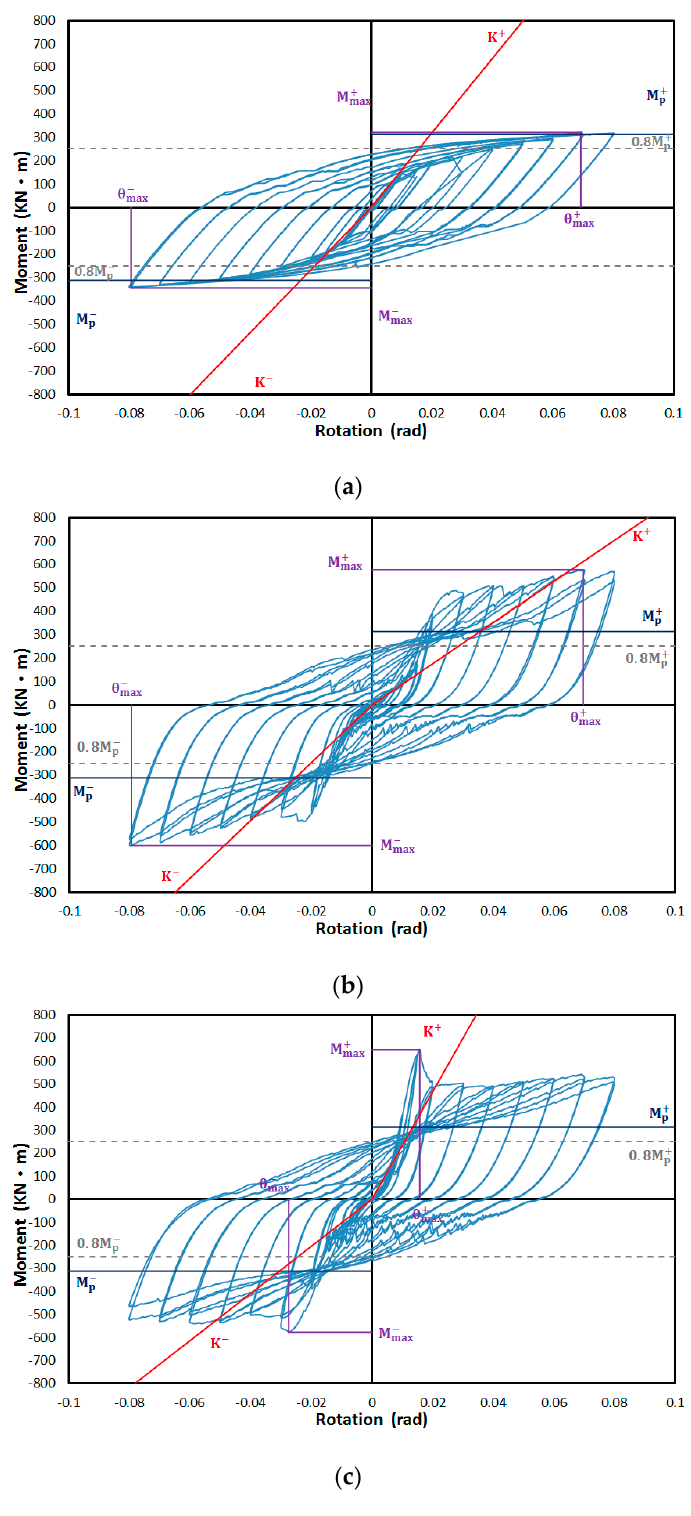
Figure 9. Hysteresis curves of the specimens: ( a ) FR-00; ( b ) FR-TR-V; ( c ) FR-TR-H.